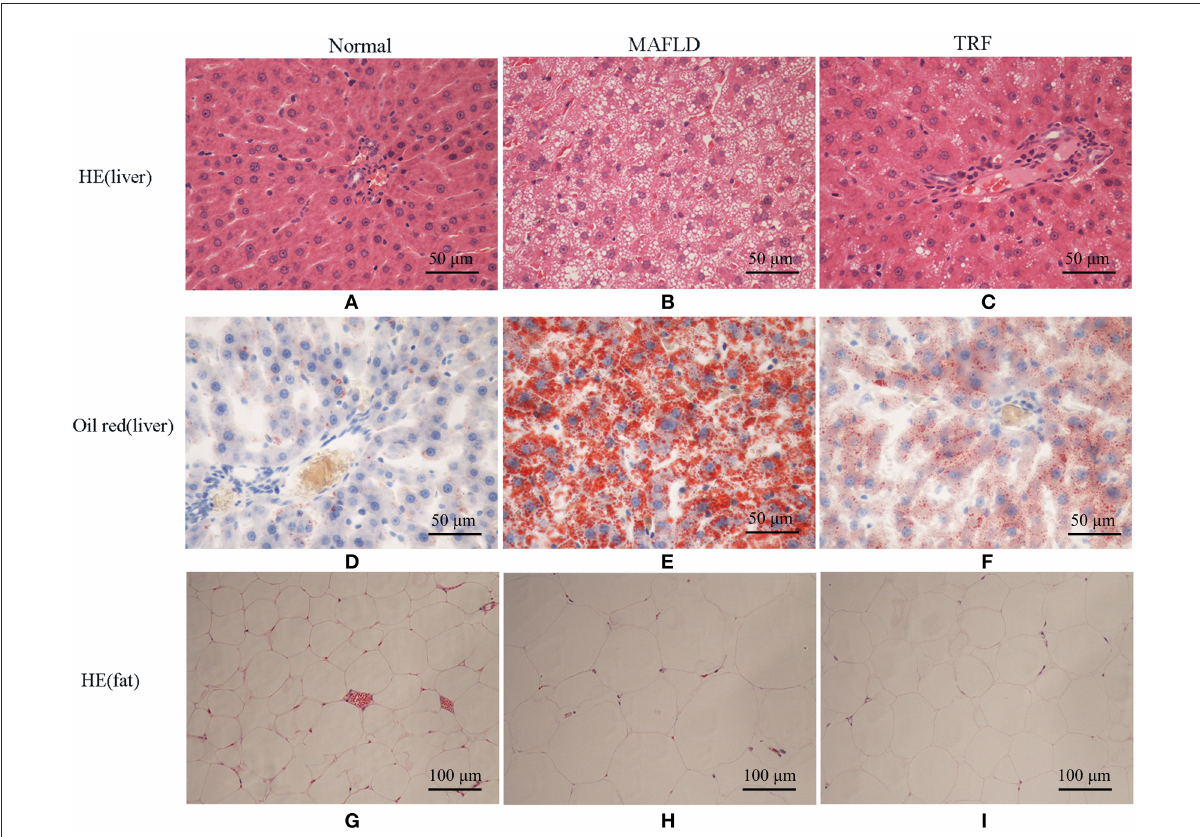
FIGURE4 Pathological results of Normal group, MAFLD group and TRF group. (A–C) HE staining, (D–F) oil red staining of liver tissue ( × 400), and (G–I) HE staining of perirenal fat ( × 200). Normal, rats fed a Normal diet ad libitum ; MAFLD (metabolic associated fatty liver disease), rats fed a high-fat diet ad libitum ; TRF (time-restricted feeding), rats fed high-fat diet (60 kcal% Fat) strictly between 16:00 to 22:00 every